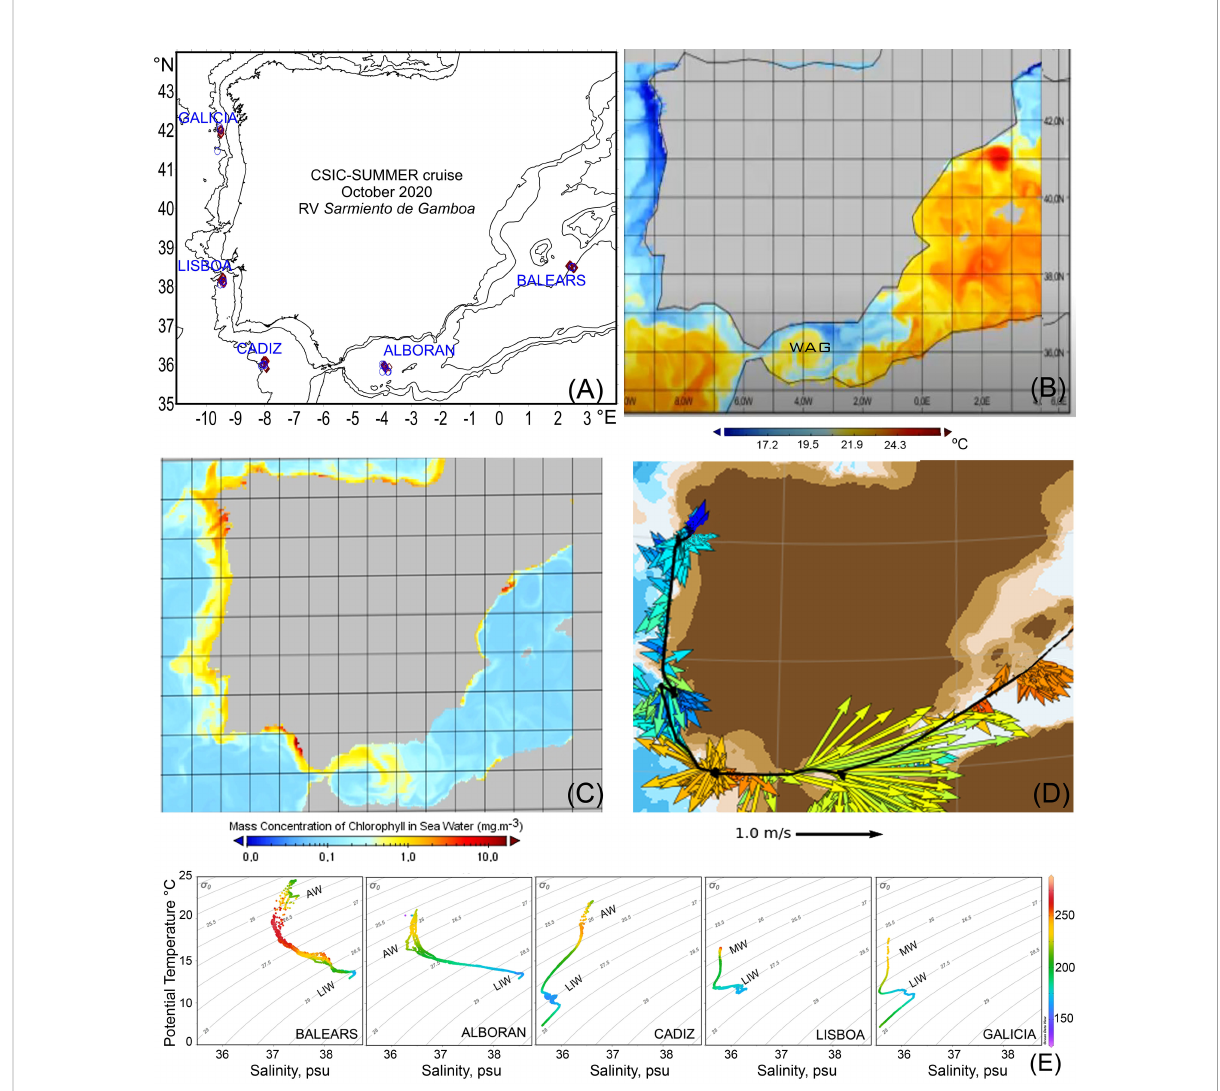
FIGURE 1 (A) Study region, showing the fi ve studied zones. Red diamonds indicate the repeated sampling stations in each zone. (B) Sea Surface Temperature (°C), (C) Chlorophyll- a (mg/m 3 ) for 10/10/2020 as inferred from the Mercator Global Ocean forecasting system and (D) Surface current from SADCP. (E) Temperature - Salinity diagrams and water masses in the fi ve studied zones along the cruise. AW, Atlantic Water; LIW, Levantine Intermediate Water; MW, Mediterranean Water. Colour scale denotes oxygen concentrations in µmol/kg. WAG, Western anticyclonic gyre. The name of each study zone follows the local